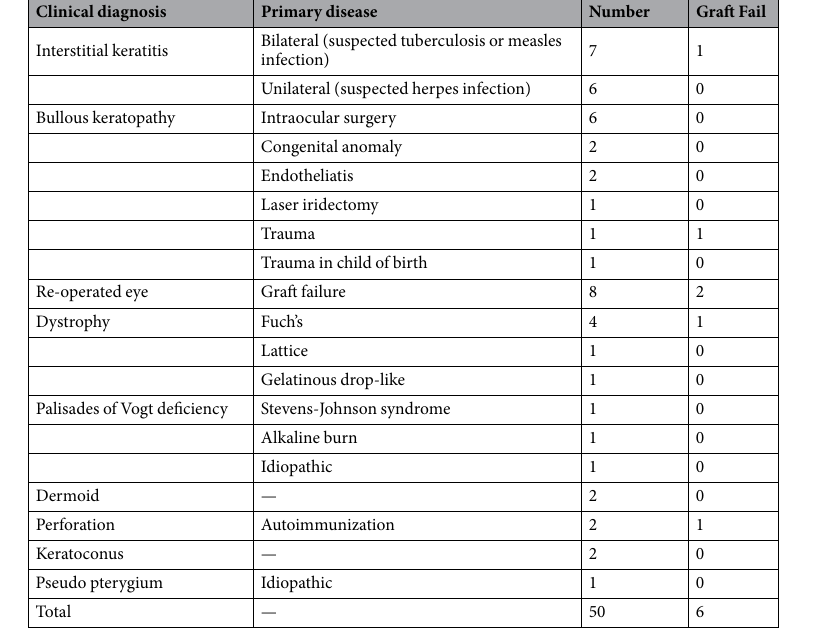
Table 1. Primary disease in patients undergoing corneal